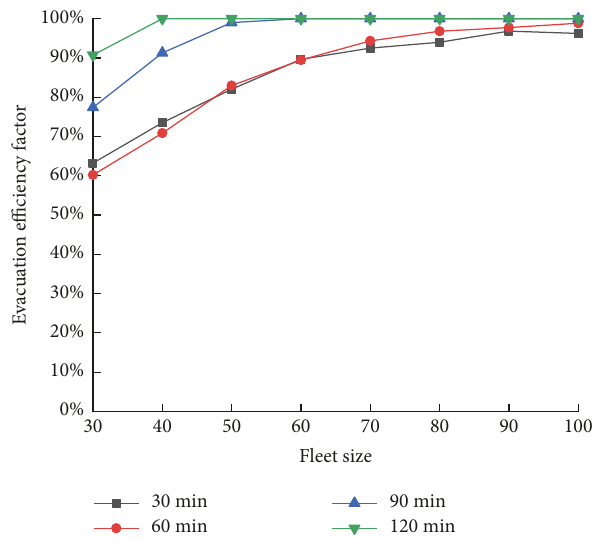
Figure 13: Performance of evacuationefficiency factor with varying bus fleet